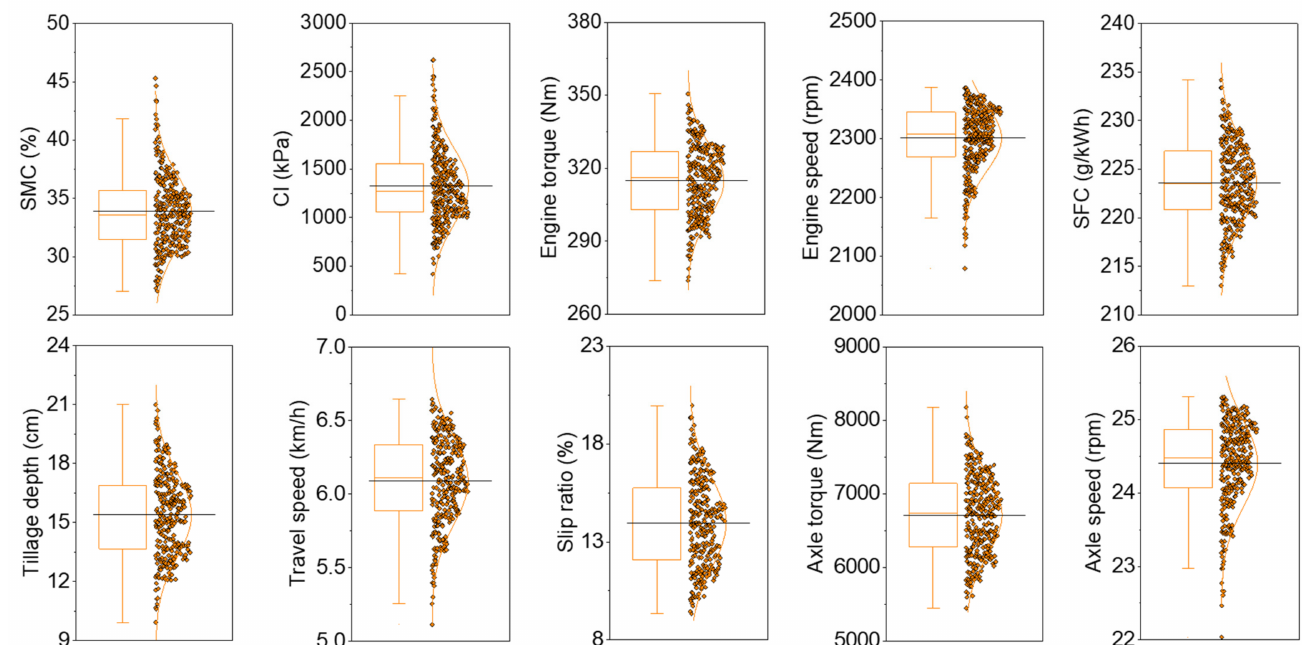
Figure 2. Boxplot analysis of the soil physical properties and major tractor